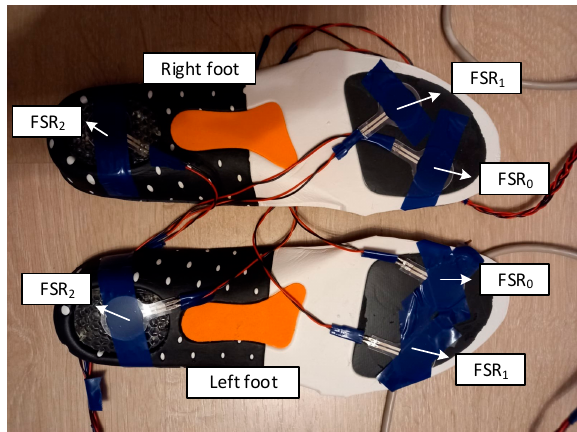
Figure 2. Illustration of the waist-worn ATmega2560 microcontroller development board, attached to a Velcro strip, which reads the peripherals involved in the bilateral monitoring of foot biomechanics and unilateral tracking of the arm balance.